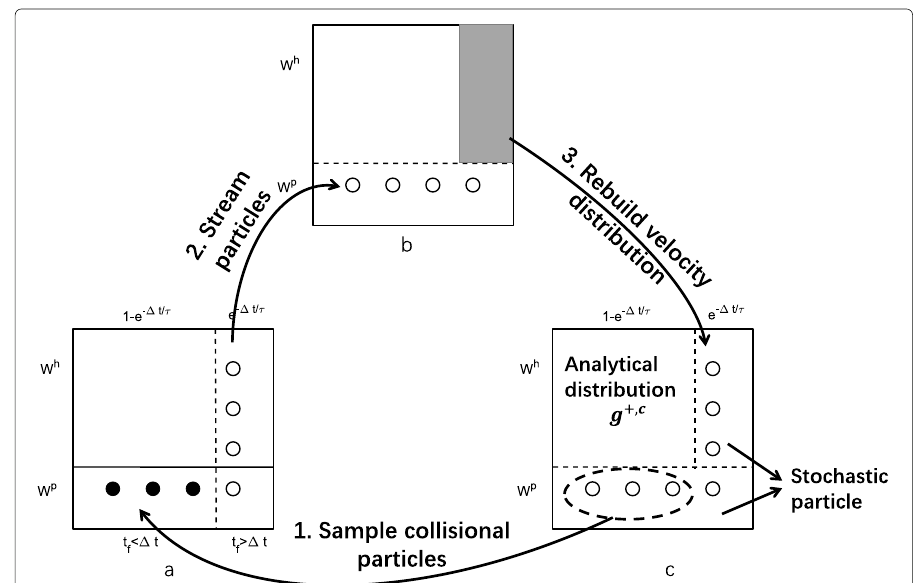
Fig. 1 The diagram of particle updating procedure: 1. Sample particle free streaming time t c , ; 2. Stream particles and update macroscopic quantities; 3. Rebuild velocity distribution